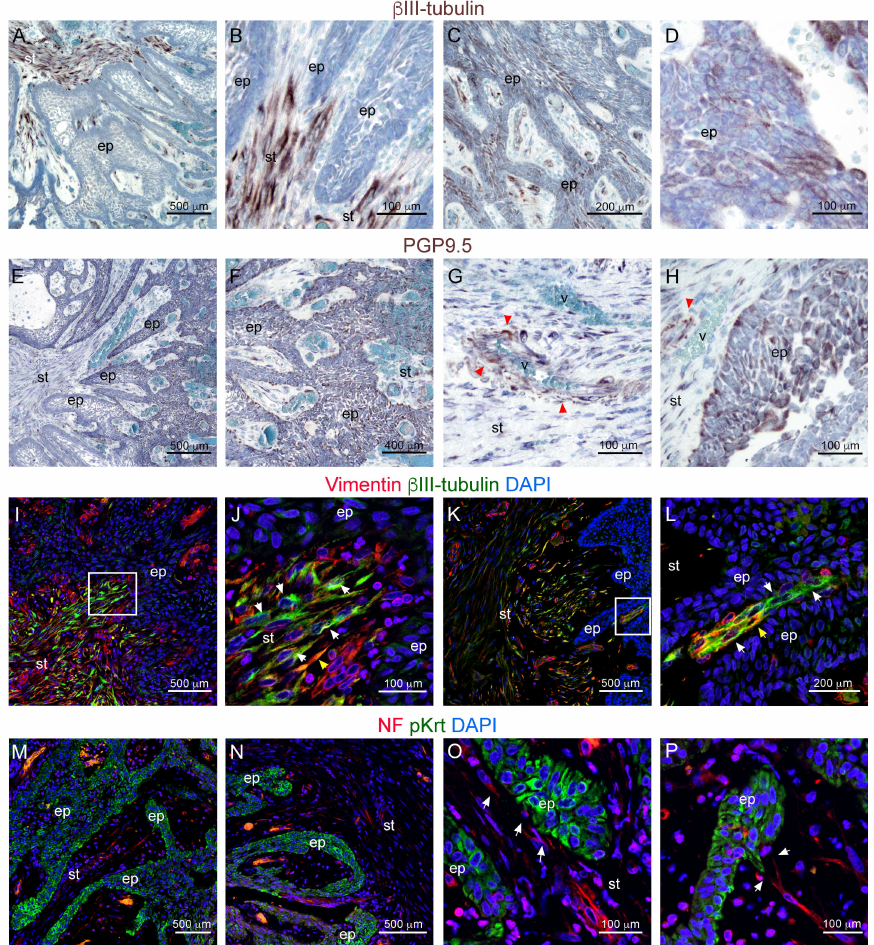
Figure 3. Innervation of ameloblastomas. ( A – H ) Immunohistochemistry against ( A – D ) β III-Tubulin (brown color) and ( E , F ) PGP9.5 on ameloblastomas. Counterstaining with Toluidine Blue (blue color). Red arrowheads: neurons associated with vessels. ( I – L ) Double immunofluorescent staining against β III-Tubulin (green color) and Vimentin (red color). Blue color: DAPI. White arrowheads: β III-Tubulin + Vimentin − nerve fibers; yellow arrowheads: double β III-Tubulin + Vimentin